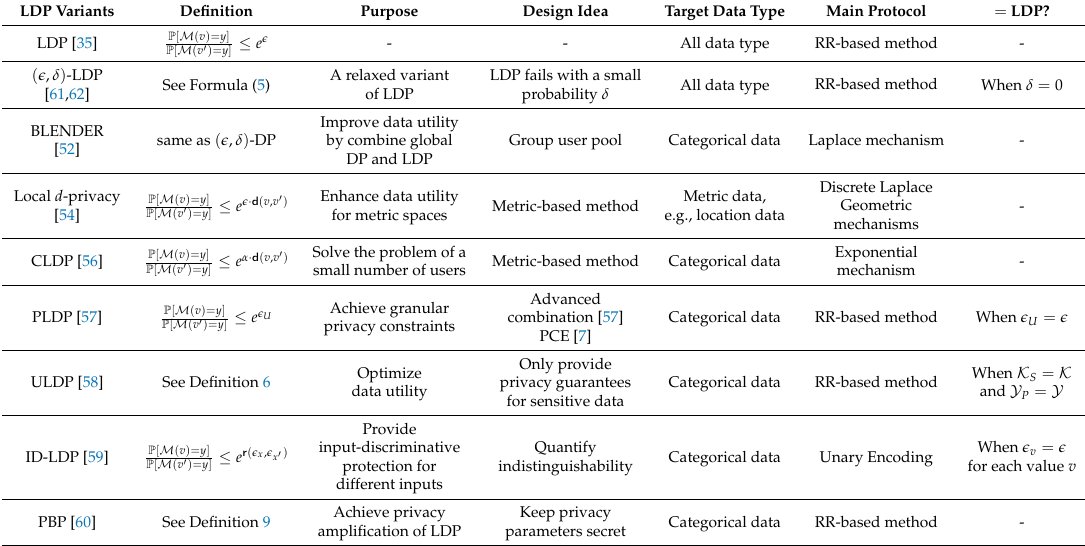
Table 3. Summary of LDP variants (LDP is also listed for